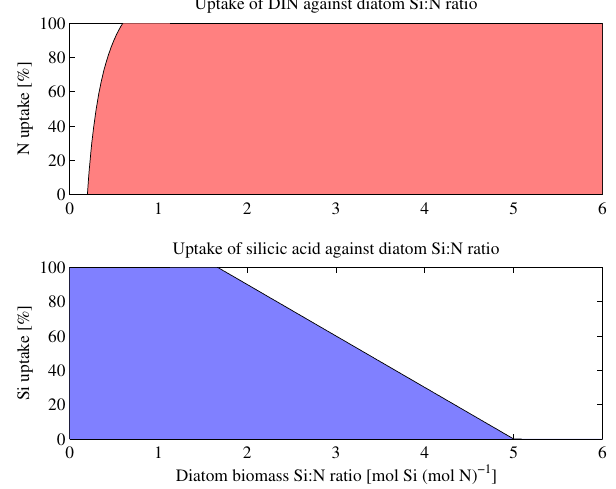
Fig. 2. Diatom uptake of nitrogen (top) and silicon (bottom) against the Si : N ratio of diatom